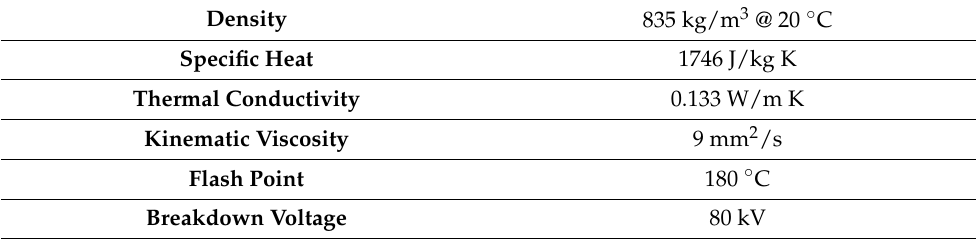
Table 6. Dielectric fluid main